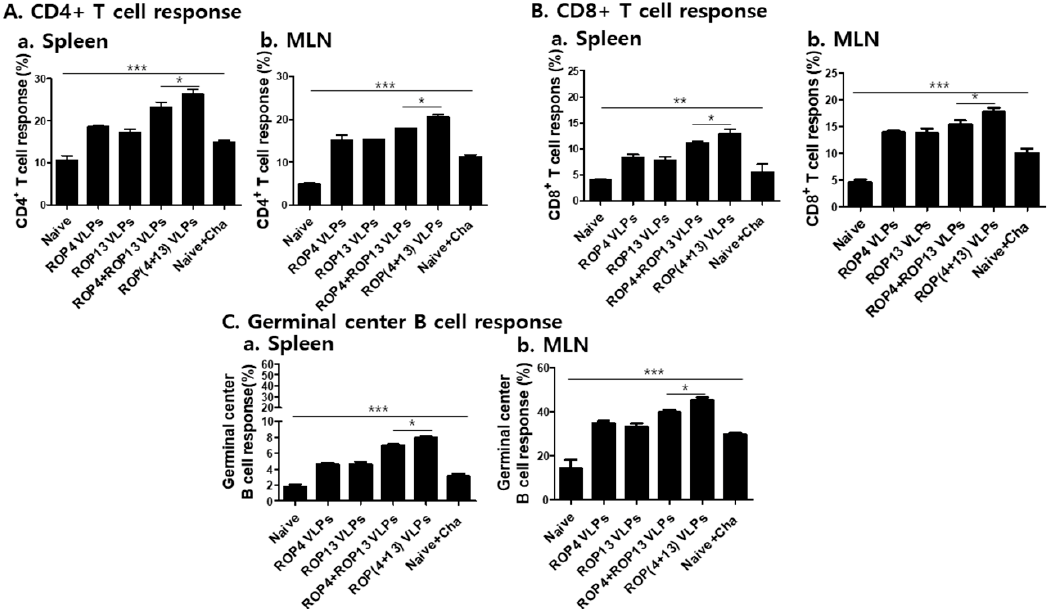
Figure 6. Flow cytometric analysis. Collected spleen and MLN cells from mice ( n = 5) were stained with specific surface markers (CD3, CD4, CD8, B220, GL7) and analyzed using FACS. CD4 + T cell response in spleen ( A - a , * p < 0.05, *** p < 0.001). CD4 + T cell response in MLN ( A - b , * p < 0.05, *** p < 0.001). CD8 + T cell response in spleen ( B - a , * p < 0.05, ** p < 0.01). CD8 + T cell response in MLN ( B - b ). Germinal center B cell response in spleen ( C - a , * p < 0.05, *** p < 0.001). Germinal center B cell response in MLN ( C - b , * p < 0.05, *** p < 0.001).